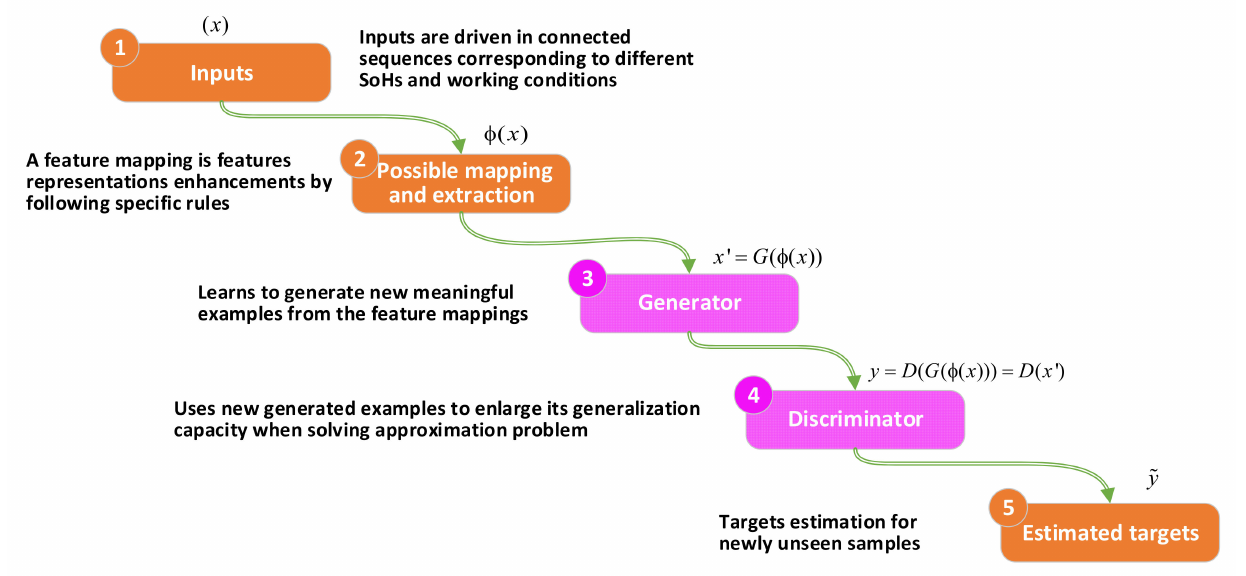
Figure 15. Using GMs for supervised